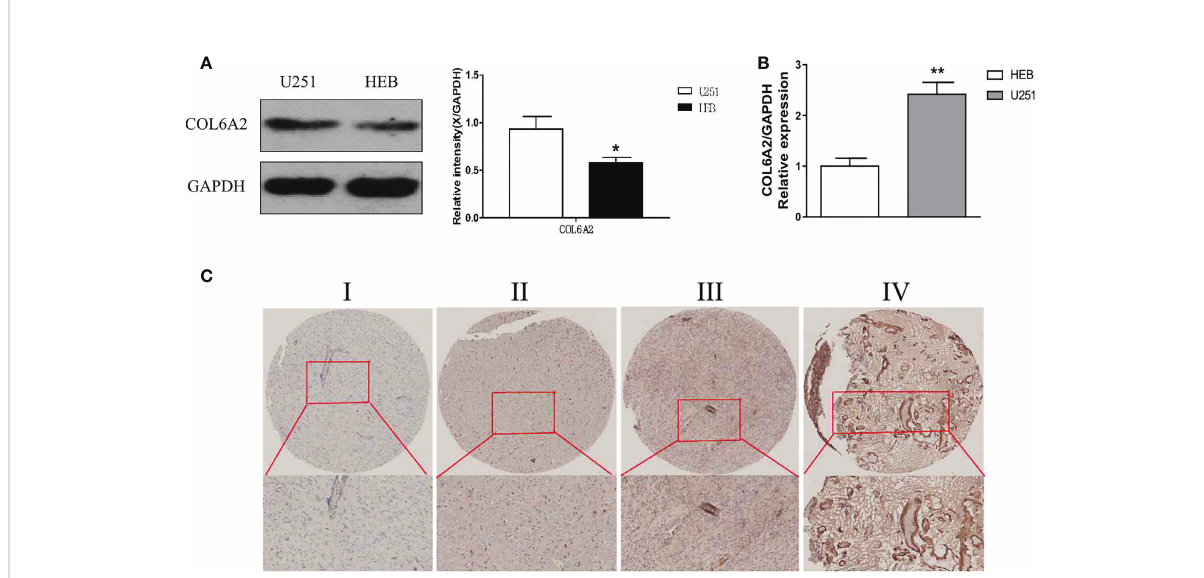
FIGURE 2 Expression of COL6A2 in human glioma cells. (A) The protein levels of COL6A2 in human glioma cells. (B) The mRNA levels of COL6A2 in glioma cells as shown by qPCR analyses (*p<0.05, **p<0.01). (C) IHC assay determined COL6A2 expression in different WHO grades glioma tissues. I: WHO I, II: WHO II, III: WHO III, IV: WHO IV.